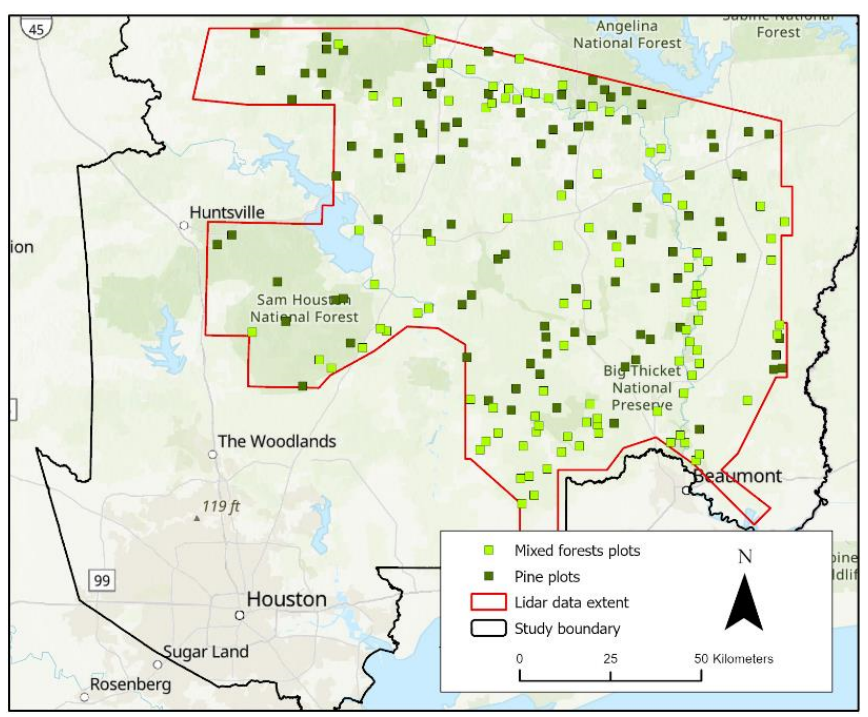
Figure 2. Plot sampling for pine and mixed forests for stem volume modeling. The sampling was limited to the extent of the collected airborne lidar data. A total of 200 plots, equally divided between pines and mixed forests, were